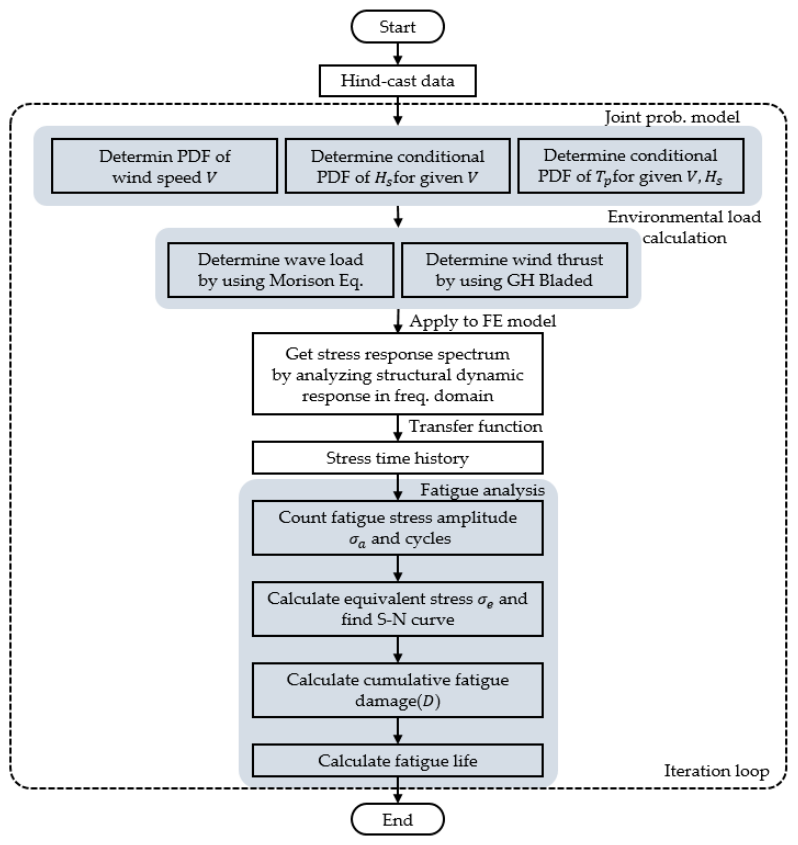
Figure 7. Flowchart for probabilistic fatigue analysis.